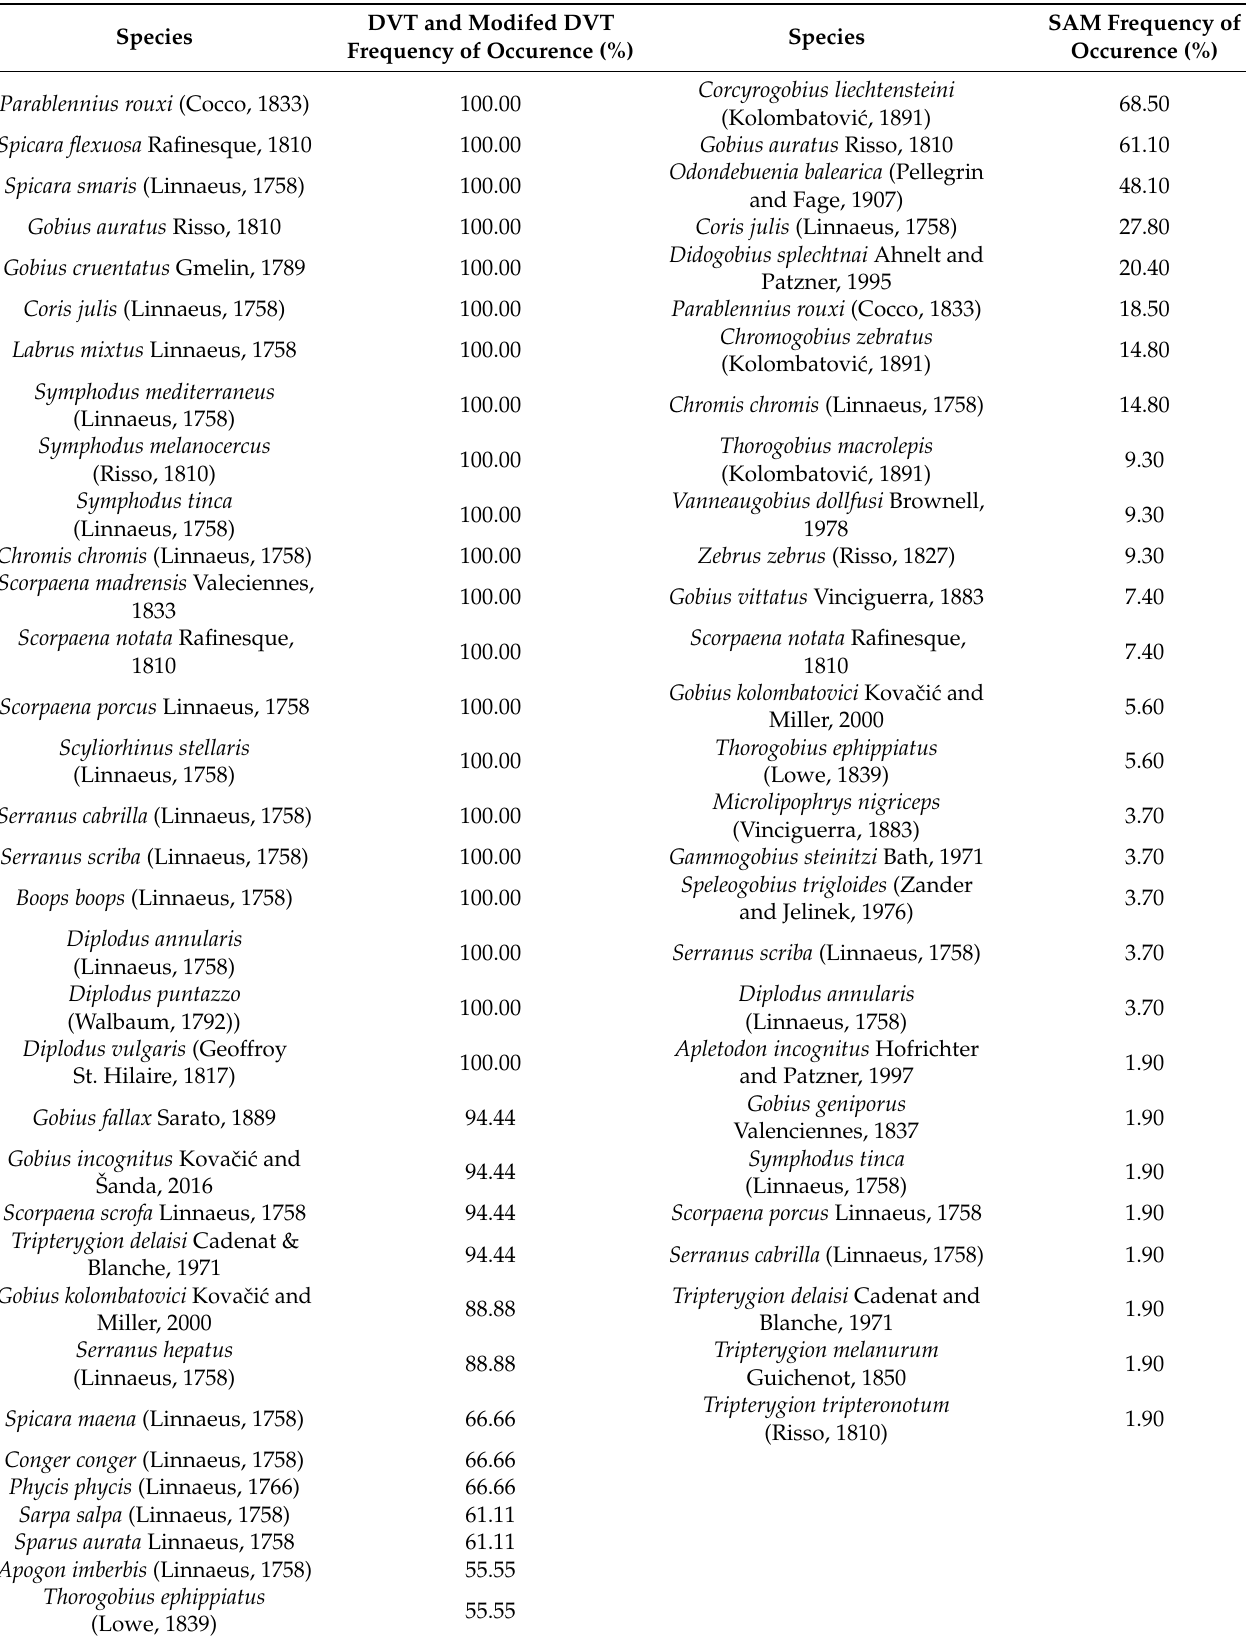
SAM Frequency of Species Occurence